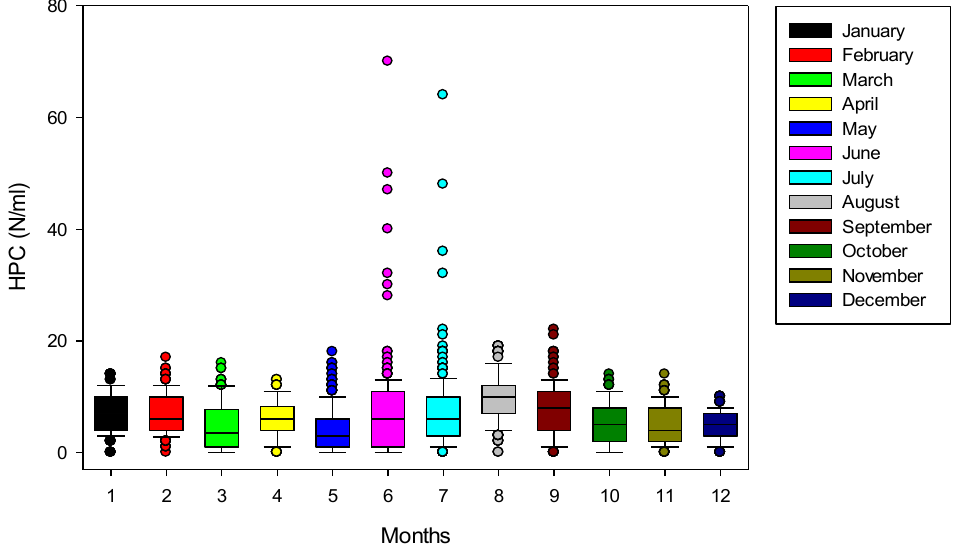
Figure 5. Heterotrophic plate count (HPC) bacteria measured at temperature T = 22°C during one year of monitoring of all the ships used to deliver drinking water from Naples to the Eolian Islands. The distribution is shown by the vertical box plot as the median (lines), 25th and 75th percentiles (boxes) and 90th and 10th percentiles (whiskers). Circles mark the